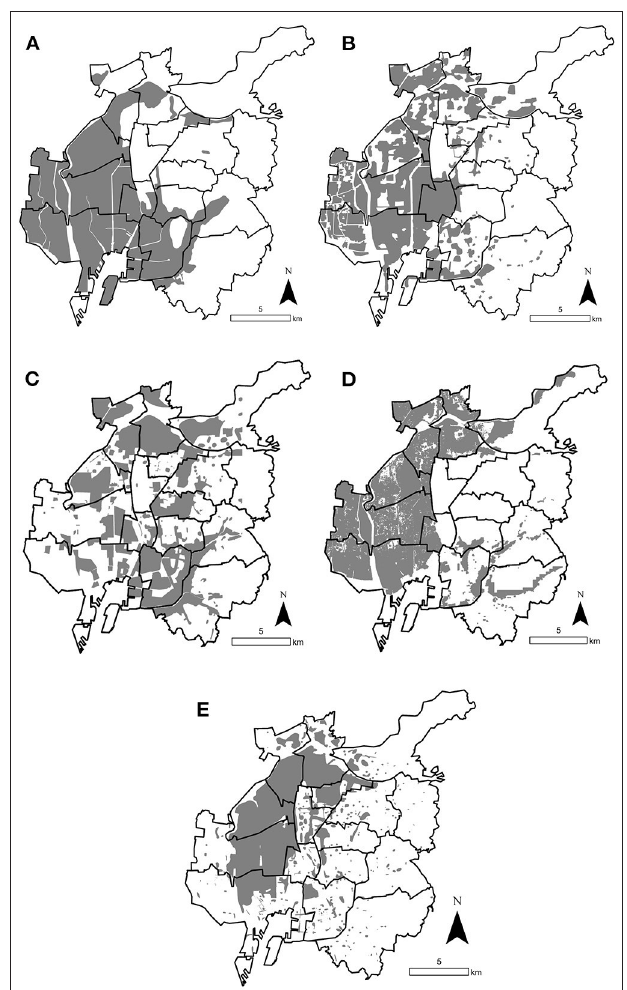
FIGURE 1 | Inundated areas and flood risk zones. (A) Inundated areas during the Isewan flood in 1959. (B) Inundated areas during the 1970’s floods. (C) Inundated areas during the recent flood in 2000. (D) Flood risk zones published in 2010. (E) Areas inundated by heavy rains in 2008, 2009, 2011, and/or 2013.